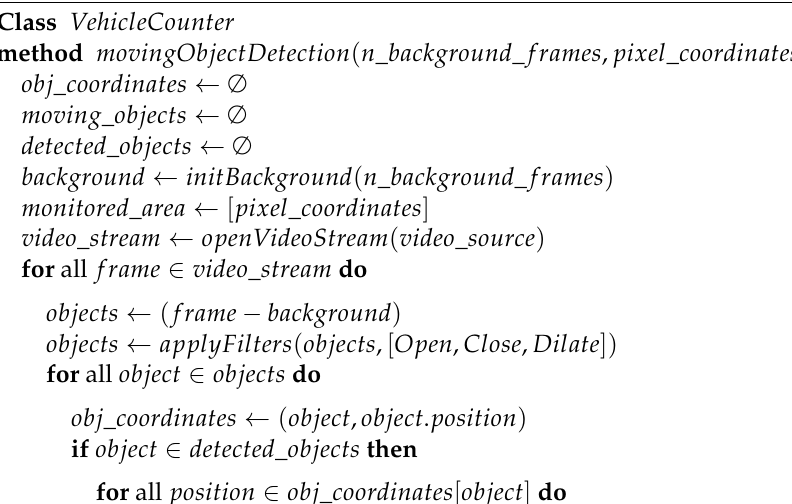
Algorithm 1 Moving object detection algorithm